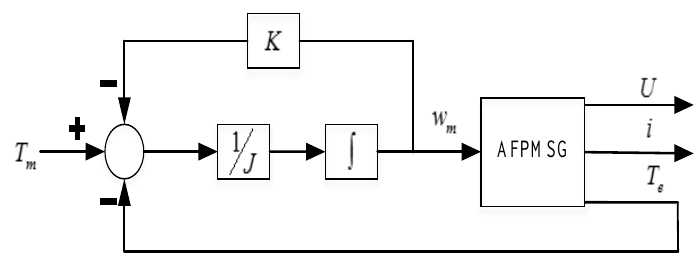
Figure 6. Dynamic characteristic analysis block diagram.